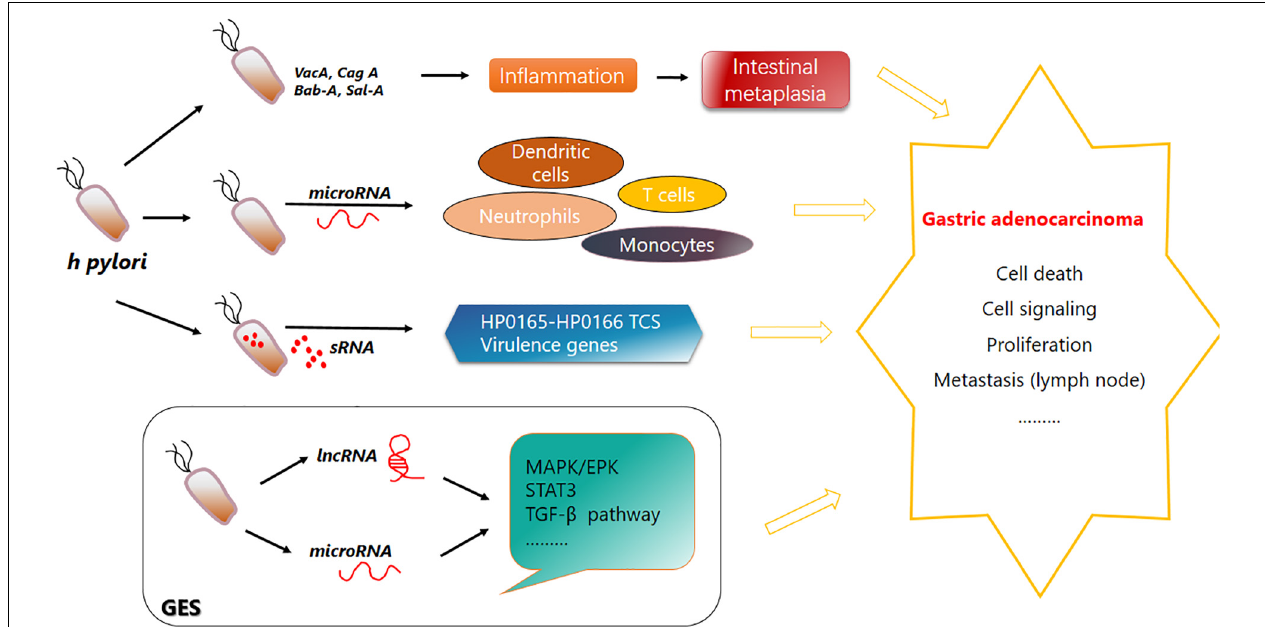
FIGURE 1 | Function of Helicobacter pylori in gastric carcinogenesis. H. pylori secretes Bab-A, Sab-A, VacA, CagA, and other substances to help invade and colonize in the human gastric mucosa and cause chronic inflammation and superficial gastritis. Its infection leads to a variety of signaling events. Immune cells such as dendritic cells, neutrophils, monocytes, and T cells can produce various microRNAs. Specific sRNA can combine with the HP0165–HP0166 two-component system to regulate the pH adaptability of H. pylori to help its inhabitation and colonization in stomach. H. pylori invasion also causes upregulation or downregulation of lncRNAs and microRNAs. Their complex regulatory network is disrupted, and pathways are affected. Bab-A, blood-group antigen binding adhesion; Sab-A, sialic acid binding protein A.